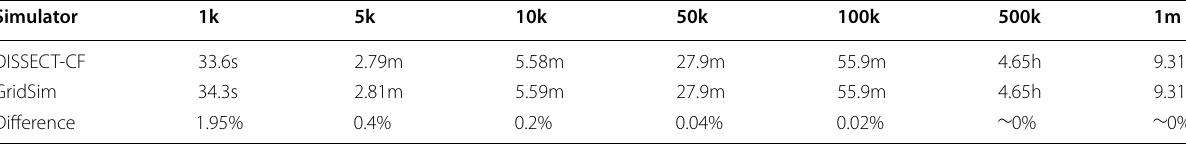
Table 5 Comparing simulating tasks using DISSECT-CF and GridSim in terms of simulated timespan Simulator